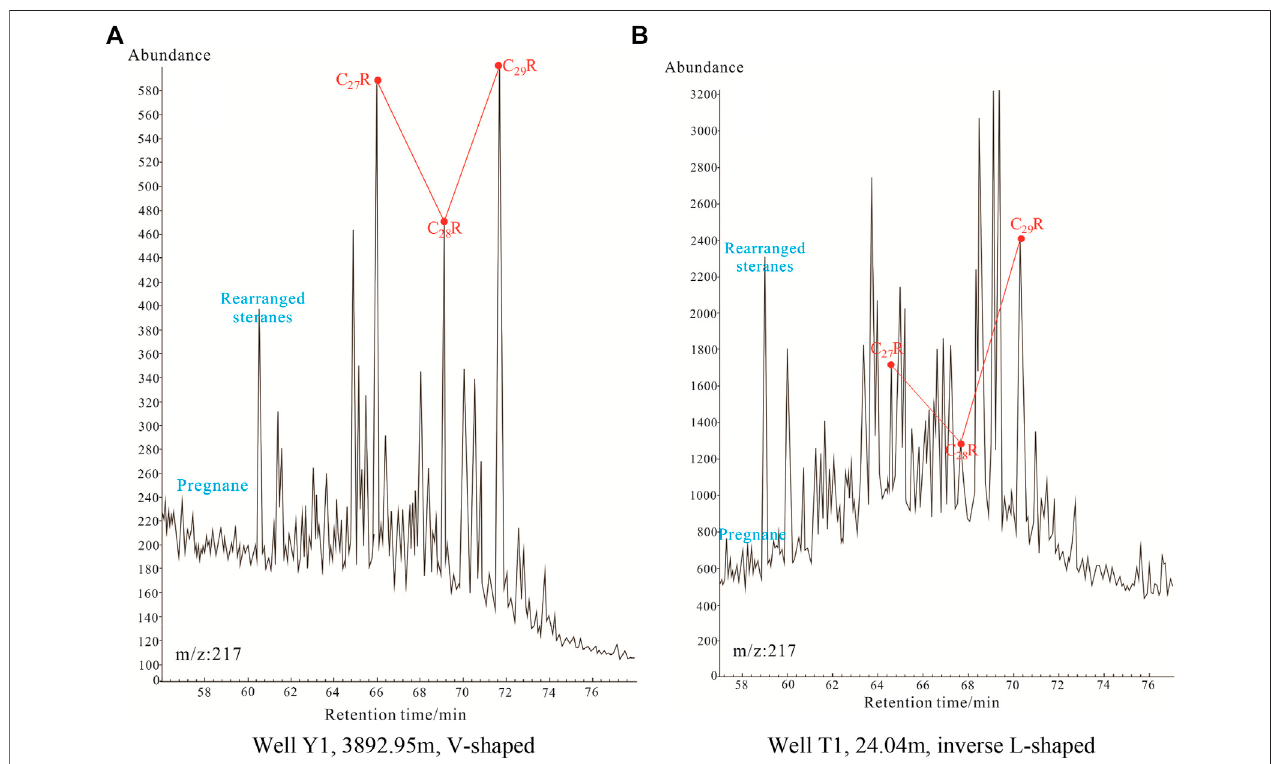
FIGURE 8 | Typical sterides chromatograms of J 1 da shale samples. (A) Well Y1, 3,892.95 m, V-shaped. (B) Well T1, 24.04 m, inverse L-shaped.